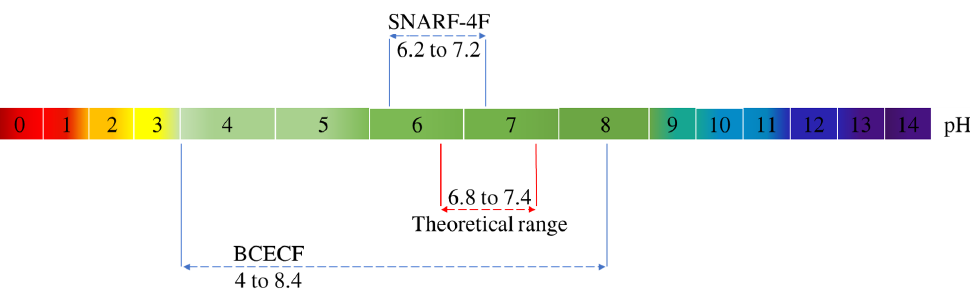
Figure 11. Validity ranges of the BCECF and SNARF-4F probes deduced from their respective calibration